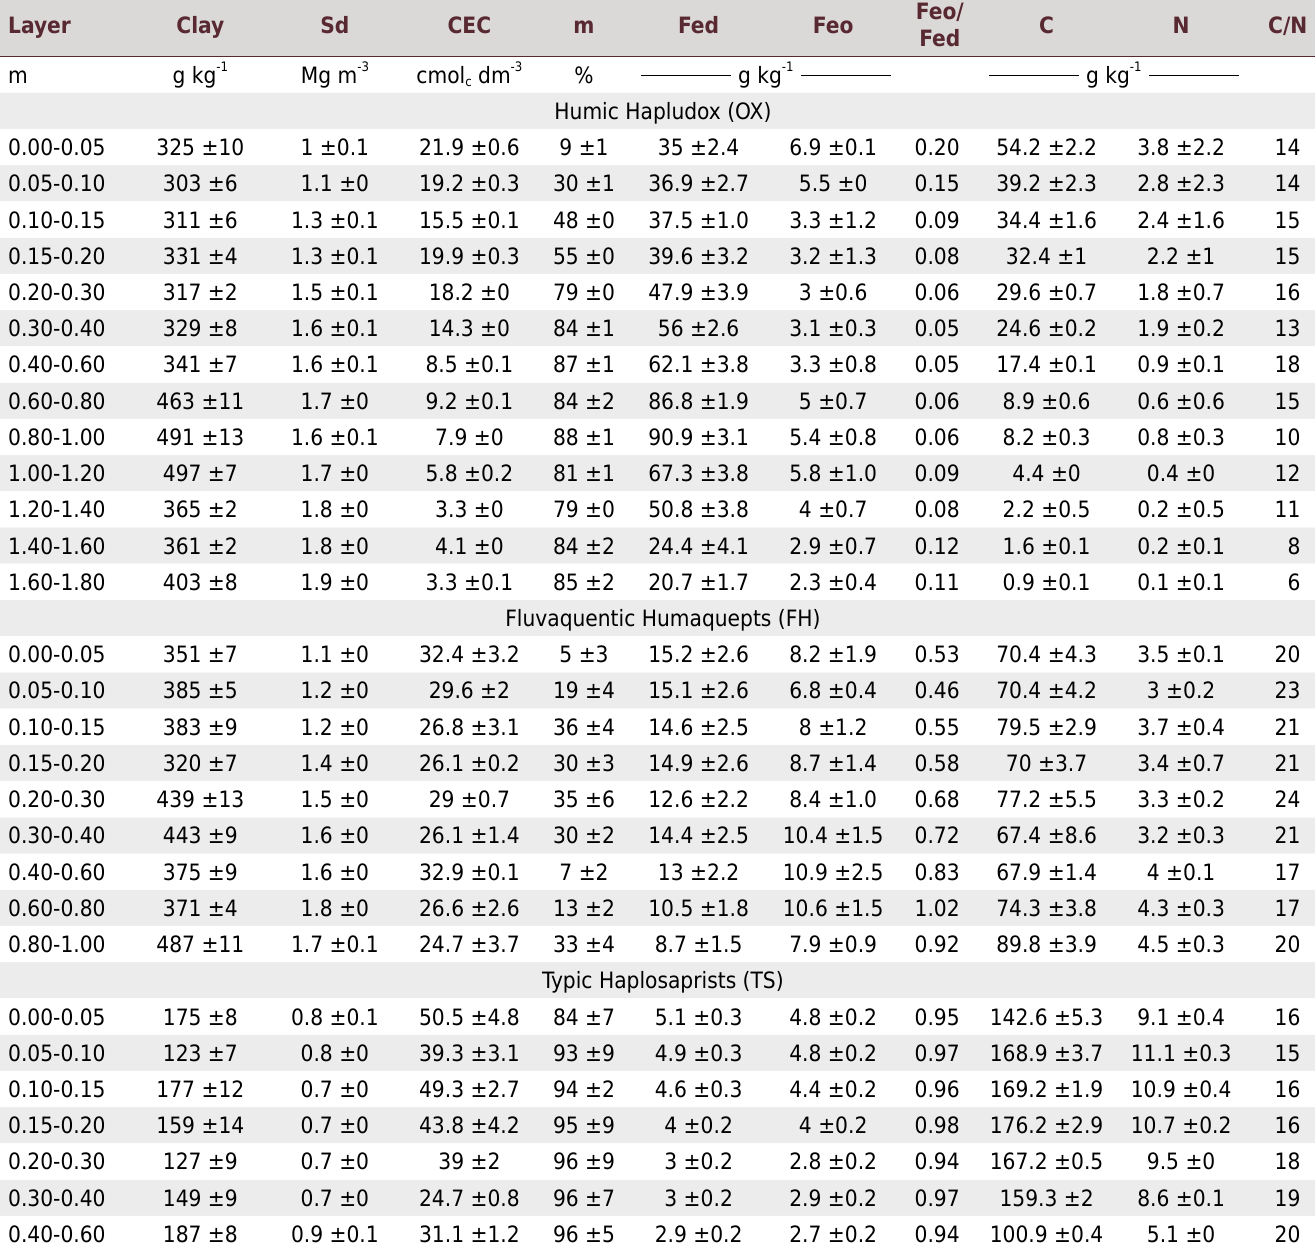
Table 2. Clay content, soil bulk density, chemical properties, pedogenic iron oxide contents, carbon and nitrogen contents of three soils in a toposequence under Araucaria moist forest in southern Brazil